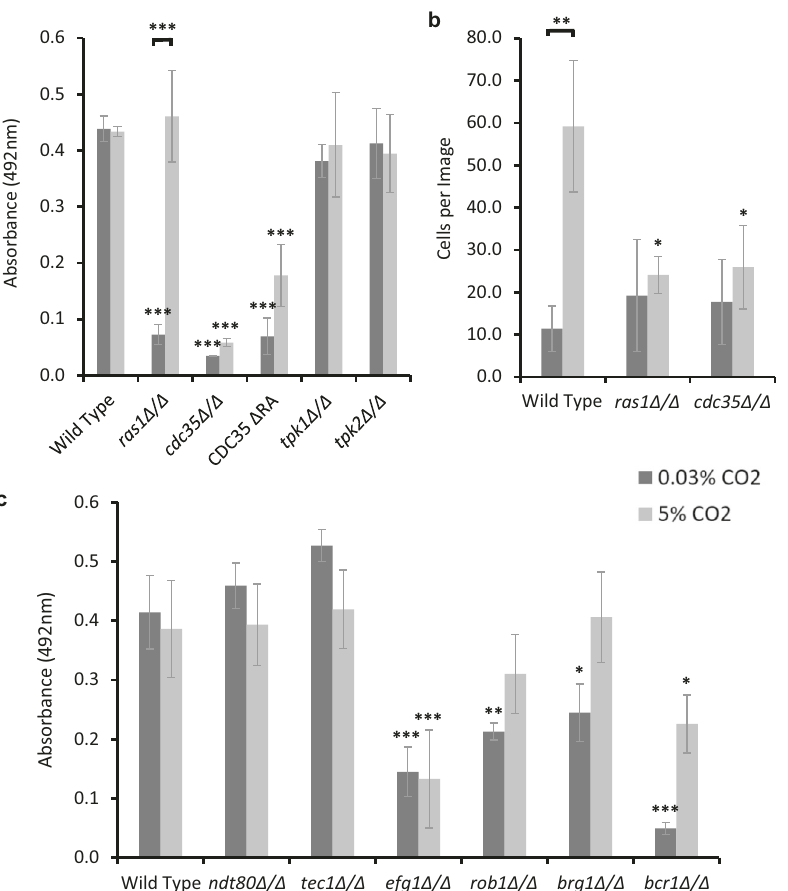
Fig. 3 Bio fi lm growth assays of C. albicans Ras1-Cyr1-PKA pathway and central bio fi lm regulator null mutants. Cells were seeded and counted or grown as bio fi lms for 48 h before XTT quanti fi cation. a Bio fi lm growth assay using Ras1-Cyr1(Cdc35)-PKA pathway null mutants. b Attachment assay on silicone surface using ras1 Δ / Δ and cdc35 Δ / Δ mutants. c Bio fi lm growth assay using central bio fi lm regulator null mutants. Graphs represent three biological replicates, error bars denote standard deviation. Two-way ANOVAs followed by Tukey tests for multiple comparisons were carried out: * p < 0.05, ** p < 0.01, *** p < 0.001. Asterisks directly above the bars indicate a signi fi cant difference to the wild type in the same CO 2